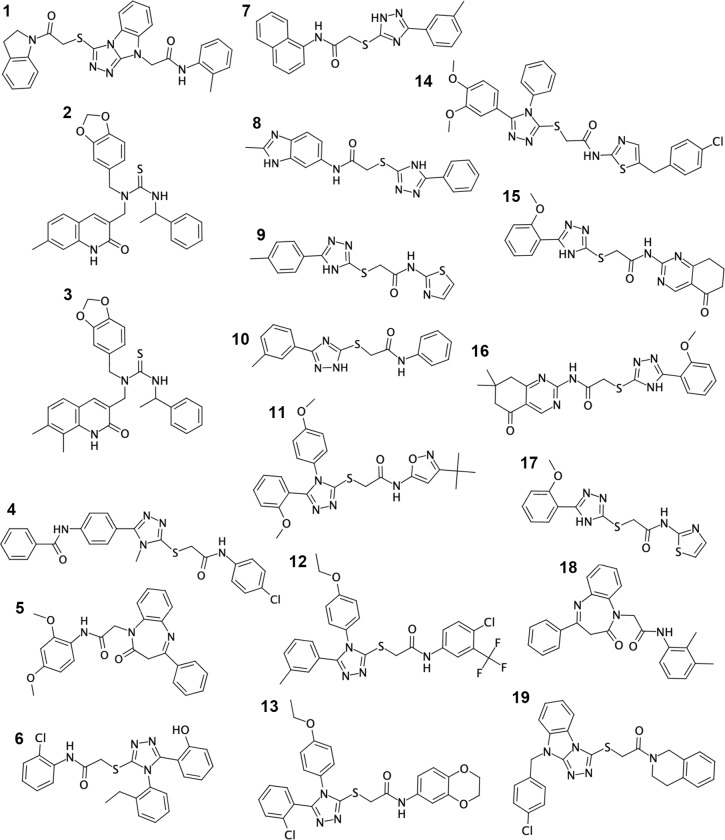
Chemical structures of the hit compounds selected through in silico HTS on GPR17.Compounds from 1 to 6 are the progenitors of the three chemical families (see also S1 Fig) identified through the earliest virtual screening. Together with compounds 4 and 6, compounds from 7 to 19 were selected among the ~1,000,000-compound library for preliminary in vitro testing. Compounds from 7 to 17 belong to Family I; compound 18 and 19 are representative of Family II and III, respectively.